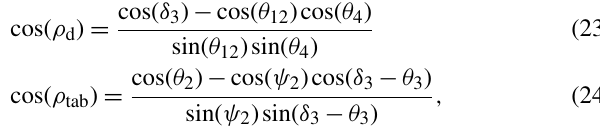
Figure 21. Sector panel ThUDS examples with (a) thickness added only beneath the joint plane and (b) thickness added both above and beneath the joint plane. Shown in flat and deployed states.